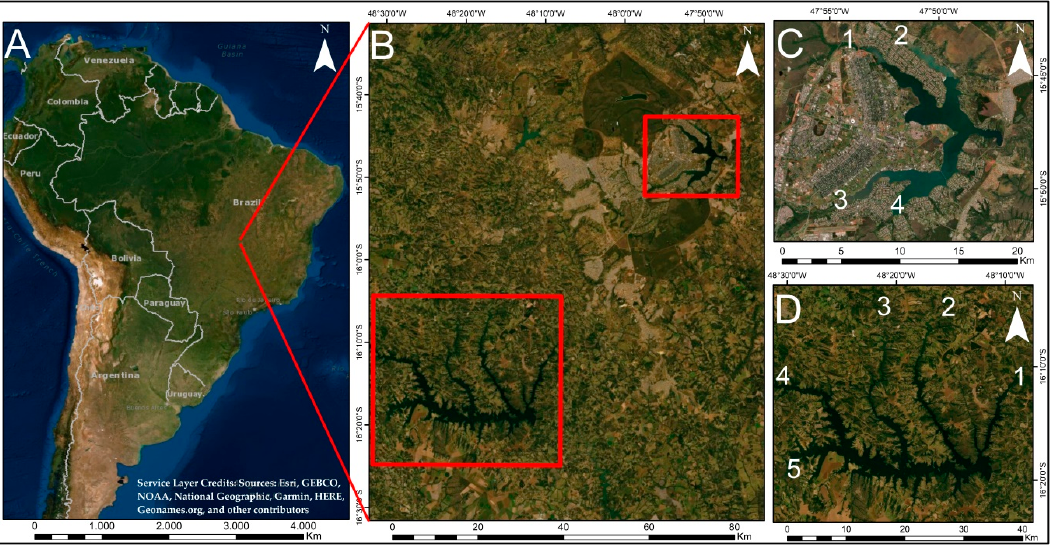
Figure 1. Flowchart of methodological procedures for TSS mapping, validation, and radiometric accuracy analysis of the unmanned multispectral platform.